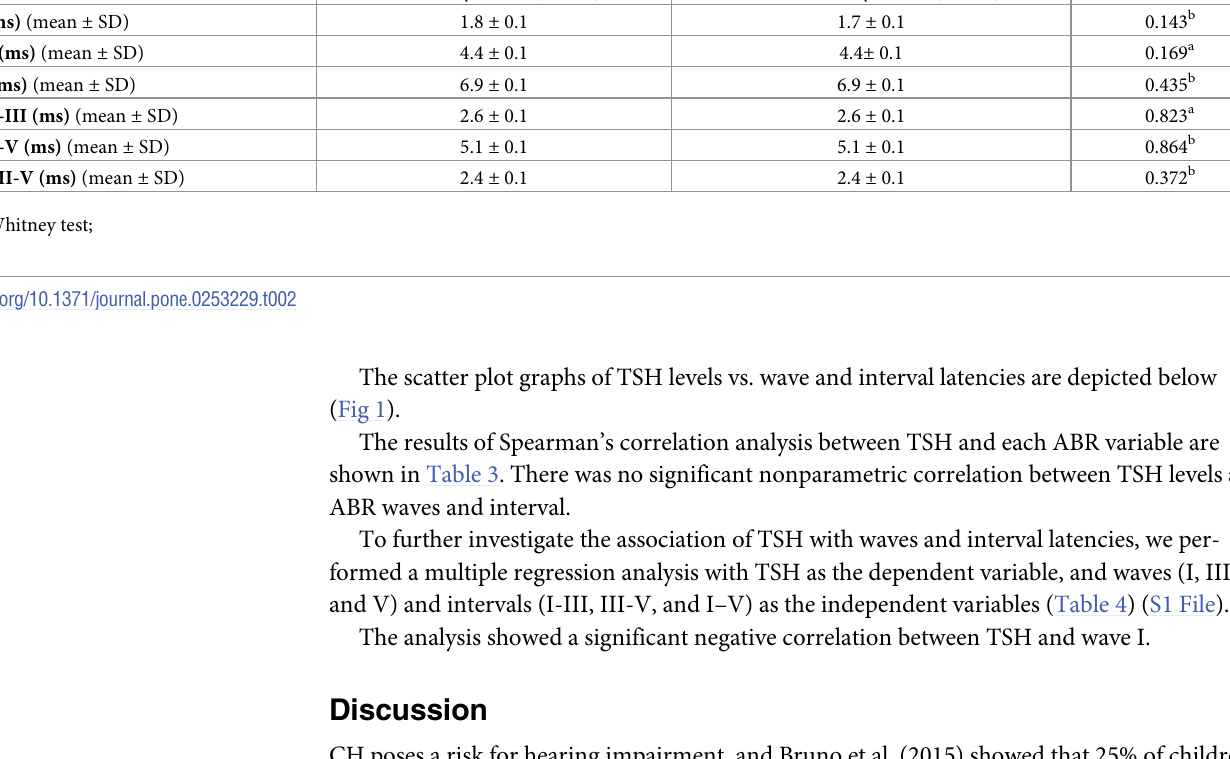
Table 2. ABR waves latencies and intervals in groups 1 and